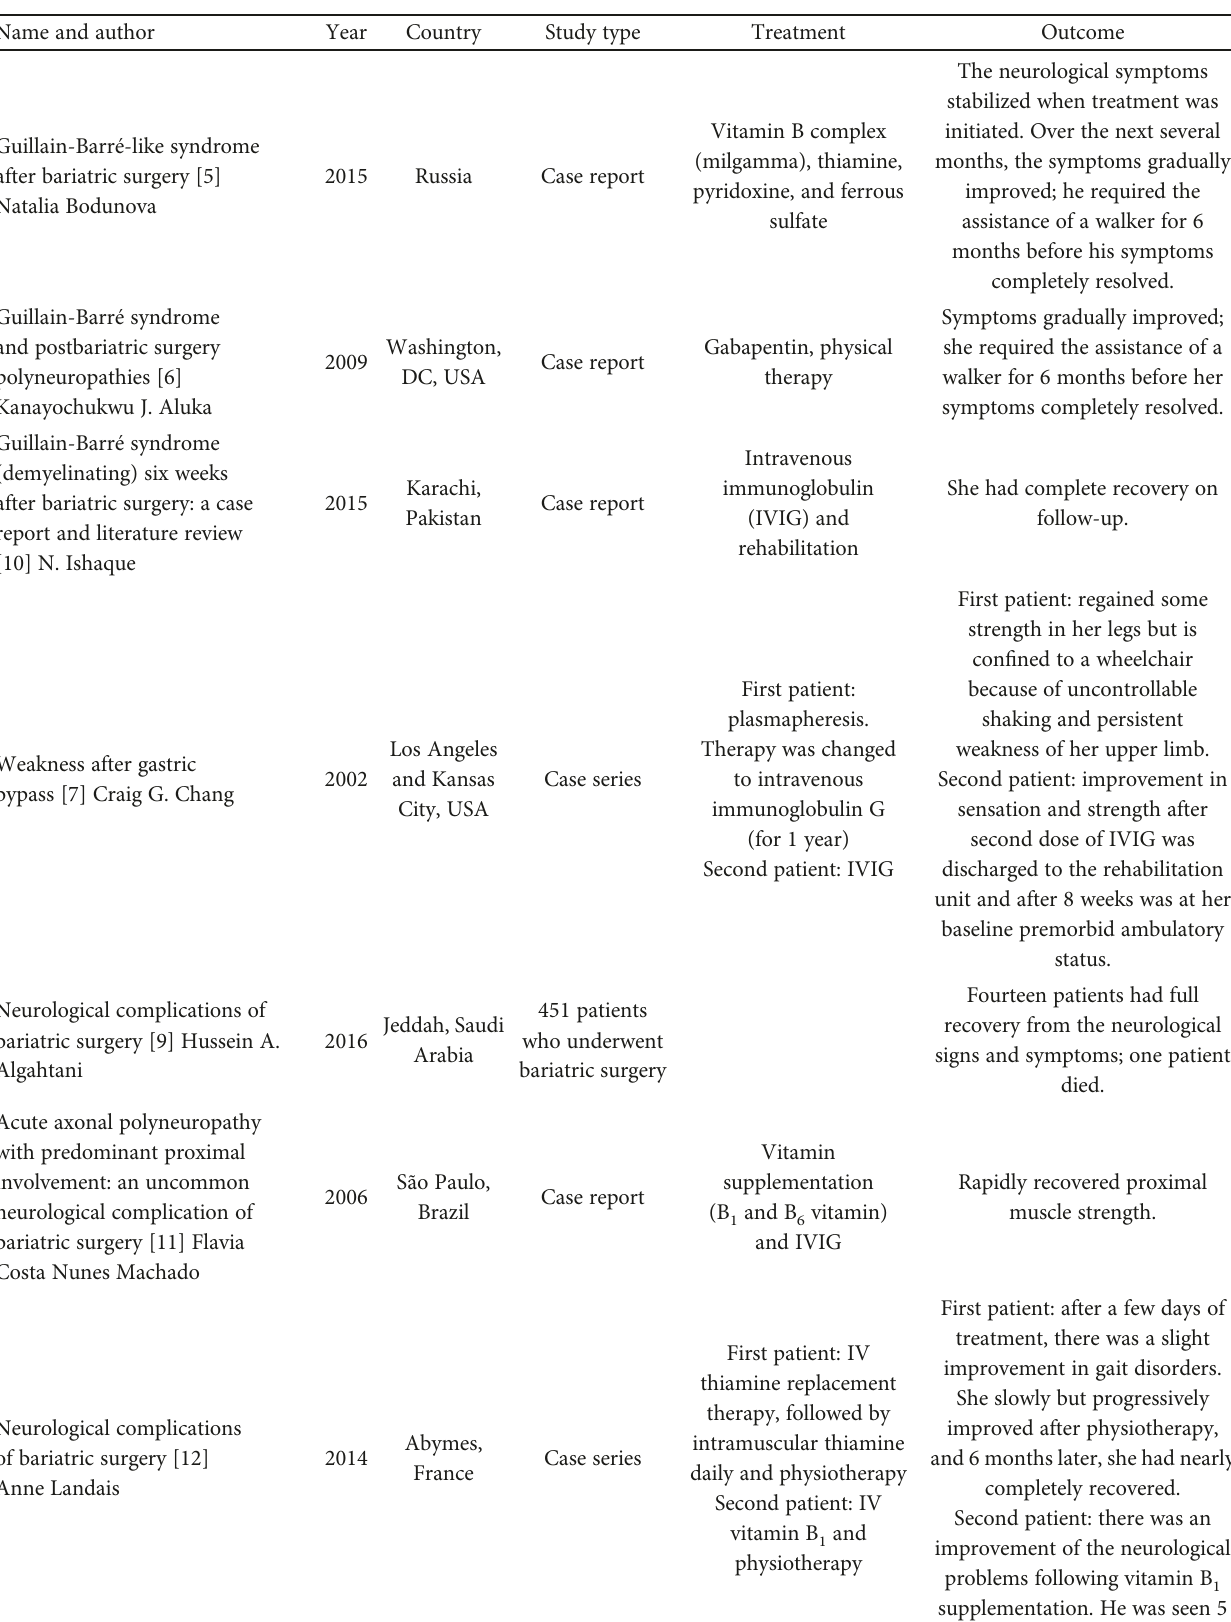
Table 1: Review of literature: GBS case reports after bariatric